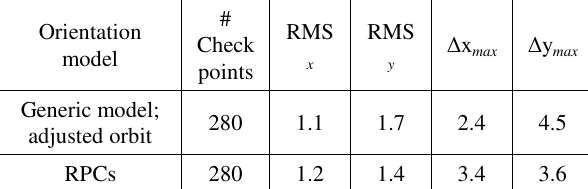
Table 1. RMS values of checkpoint discrepancies ∆ x and ∆ y in image space coordinates, in pixels, for the 55-scene strip.